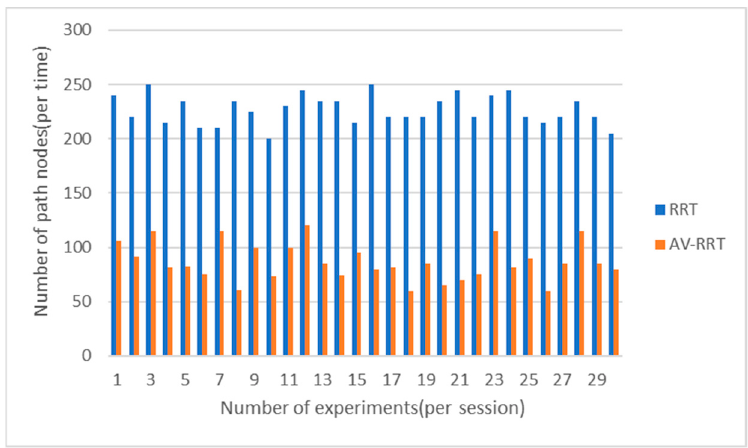
Figure 18. Comparison of the number of path nodes in the scene with sparse obstacles.